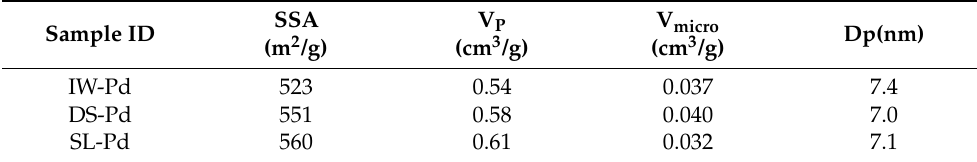
Figure 1. Physisorption isotherms ( a ) and pore size distributions ( b ) for the Pd/OMC catalysts. Table 1. Nitrogen physisorption data of IW-Pd, DS-Pd and SL-Pd.